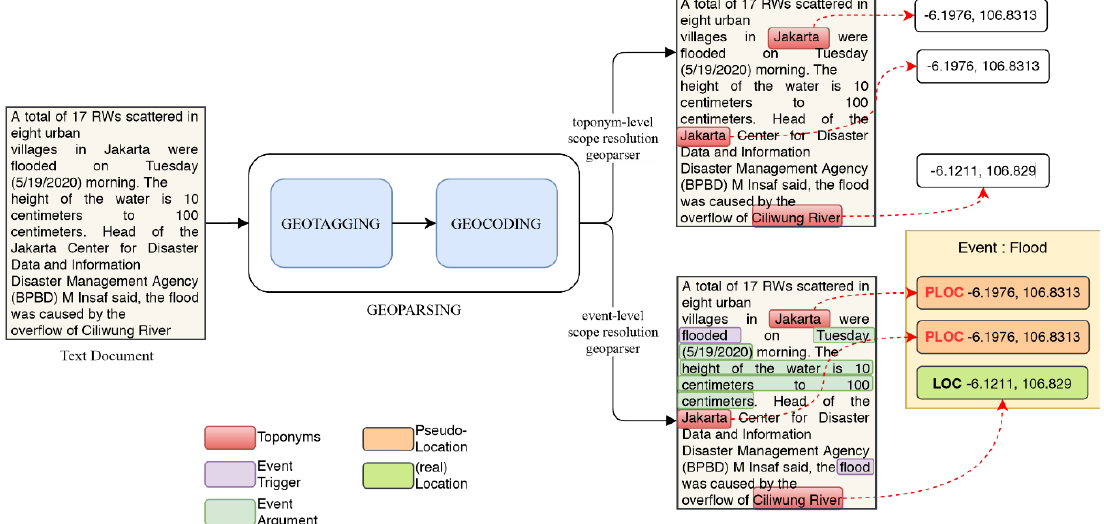
Figure 1. A comparison of toponym-level and event-level scope of resolution. Unlike toponym-level geoparser, the event geoparser is not only detecting toponym and resolving the coordinate but also detecting what event(s) happened and infering which toponym is the real location (LOC) or only pseudo-location (PLOC) with regard to that event.